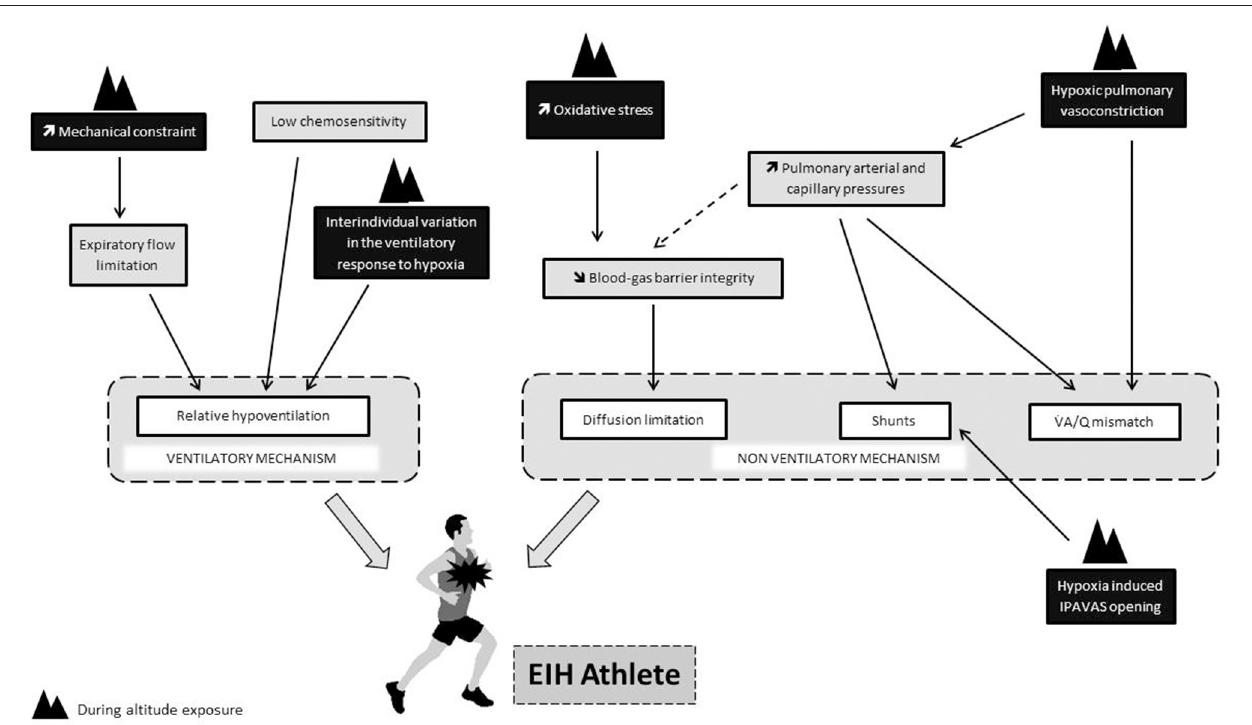
FIGURE 1 | Putative impact of hypoxia (black rectangle) on physiological determinants thought to be involved in the onset of EIH at sea level (gray rectangle). Dotted line refers to the “stress failure theory.”.